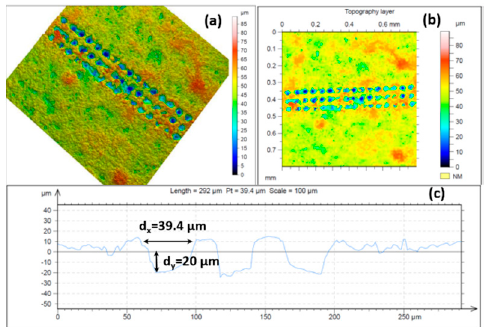
Figure 12. Confocal images of chitosan/ZrO 2 /HAp thin film irradiated at λ = 800 nm, at I = 3.1 × 10 15 W/cm 2 , τ = 130 fs, N = 1; ( a ) 3-D topography image, ( b ) topography image; ( c ) cross section of the 3-D reconstructed image.